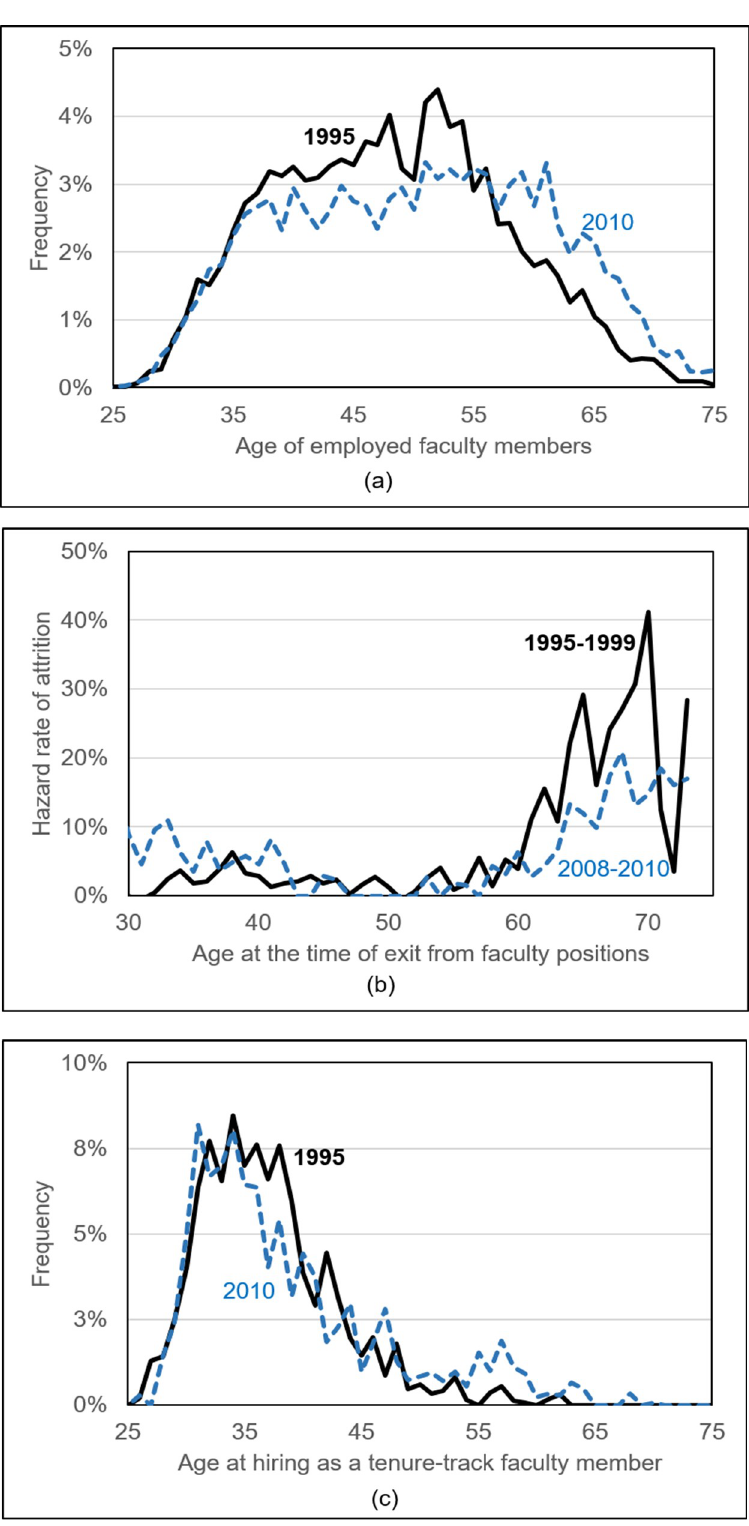
Fig 2. Age distribution pattern in US academia. (a) Age distribution of faculty in 1995 and 2010. (b) Annual hazard rates of attrition based on 1995–1999 surveys and 2008–2010 surveys. (c) Age distribution of new tenure- track hires in 1995 and 2010. Note: we define a new faculty member as a tenure-track faculty member hired within two years when observed. https://doi.org/10.1371/journal.pone.0208411.g002 PLOS ONE | https://doi.org/10.1371/journal.pone.0208411 December26,